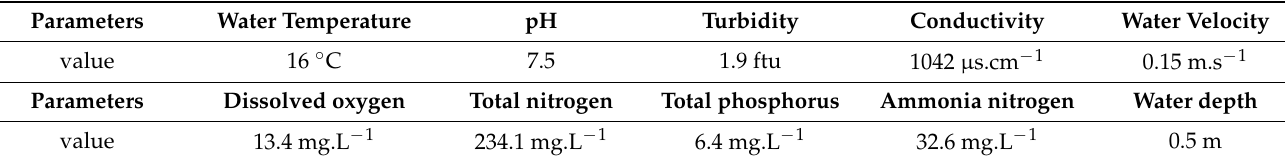
Figure 2. Herbarium specimen of Chara zhengzhouensis from Henan, China (deposited in SXU her- barium). Prepared and scanned by Q. Y. Song. 2.4. Sequence Amplification